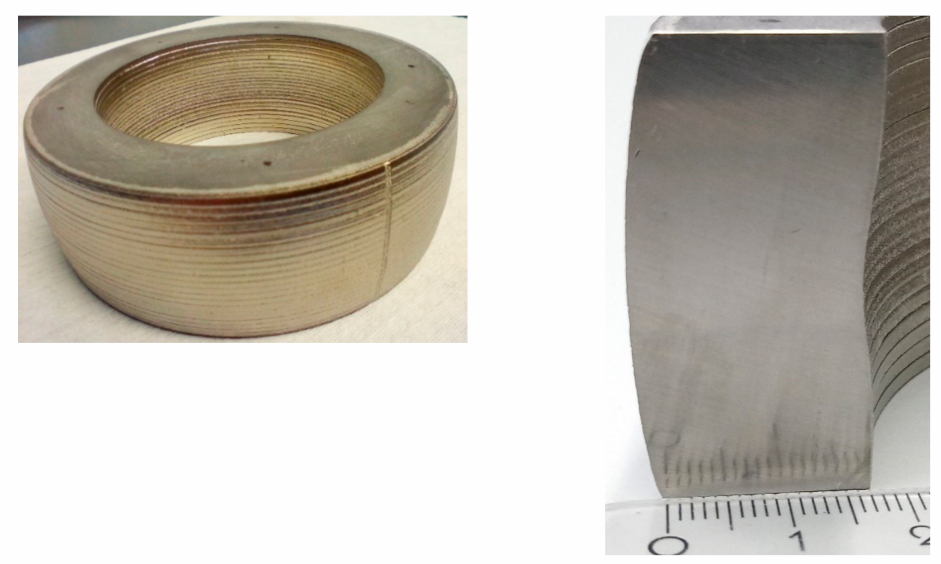
Figure 3. Characteristic shape of distortion of annular samples. Left : Overview. Right : Cross-section.